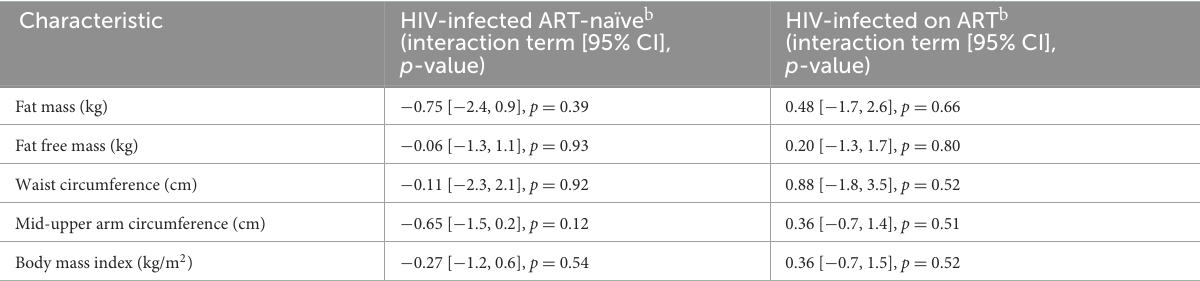
TABLE 3 Effect modification by HIV status on the association between schistosome infection and measures of adiposity (interaction terms with 95% confidence intervals) a .